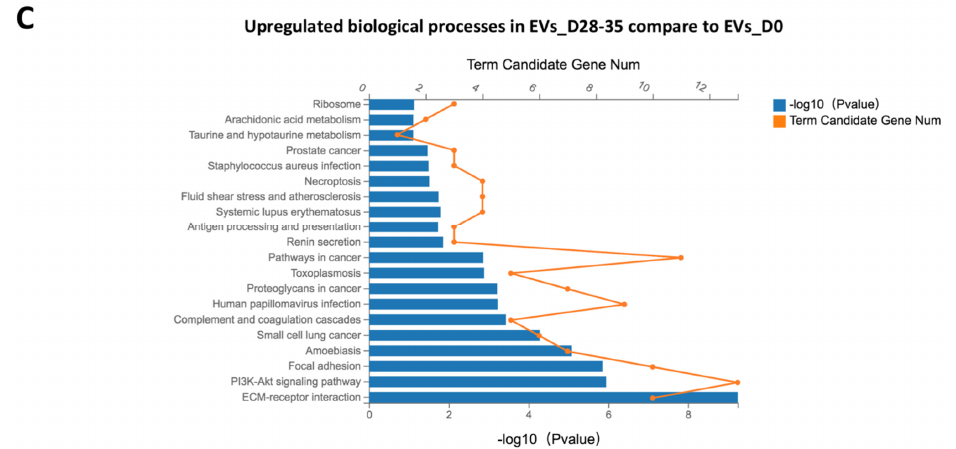
Figure 8. Functional enrichment analysis of significantly regulated proteins. Gene ontology (GO) analysis for the top 20 terms of upregulated cellular components ( A ), molecular functions ( B ), and biological processes ( C ). Kyoto Encyclopedia of Genes and Genomes enrichment analysis for significant proteins were clustered, and the top 20 pathways are shown; n = 3. Note: − log10 ( p = 0.05) = 1.30 (the bottom horizontal axis number). − log10 ( p = 0.01) = 2. − log10 ( p = 0.001) =